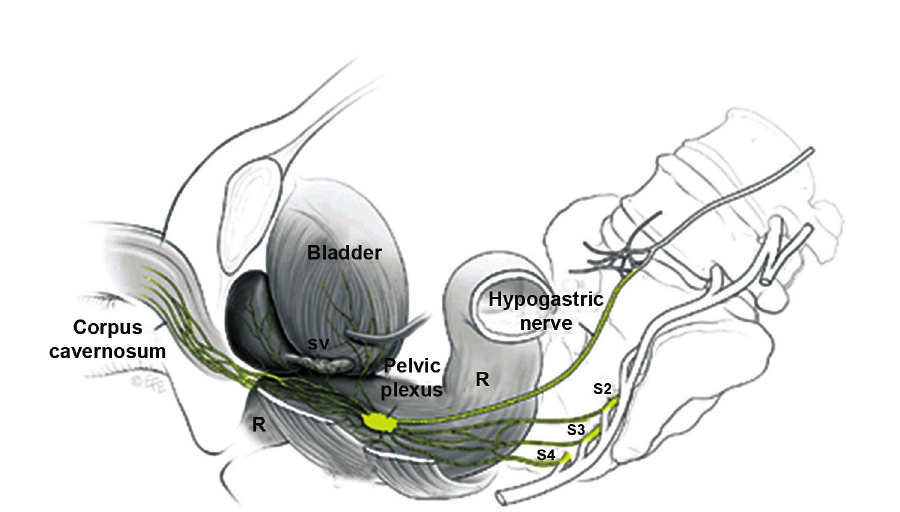
Figure 1 – The pelvic plexus and formation of neurovascular bundles, reprinted from Costello et al. (9) (with permission from Wiley- Blackwell